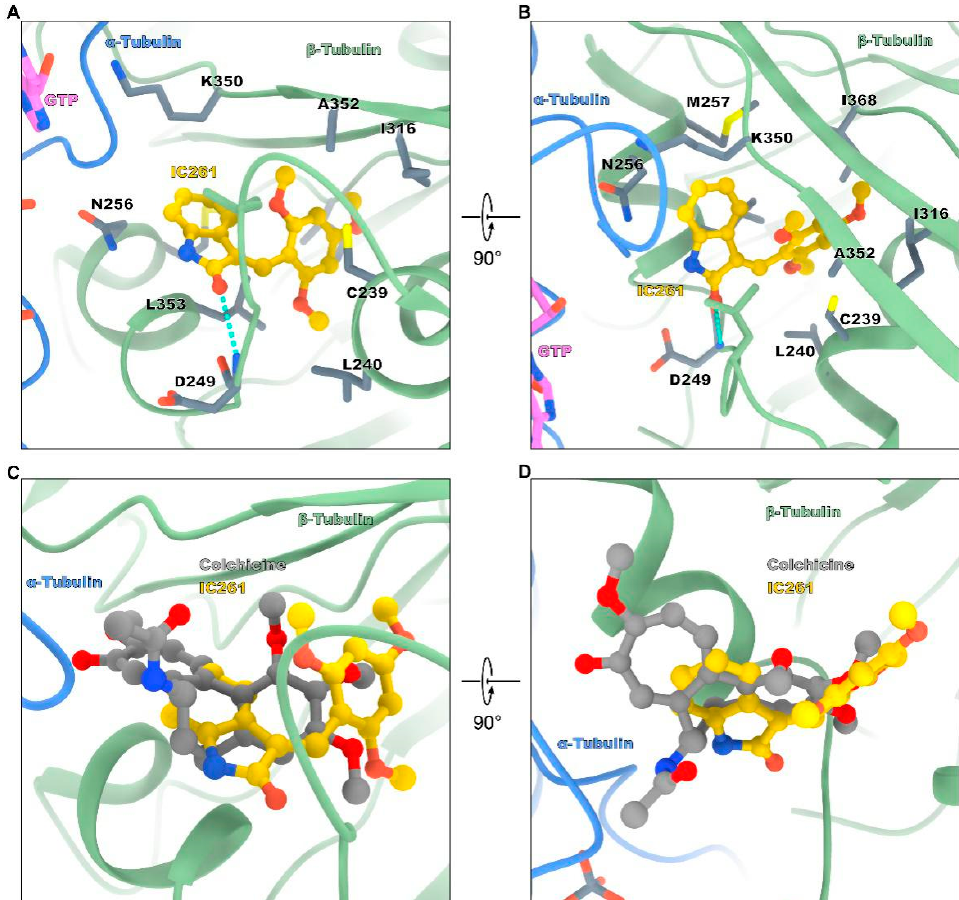
Figure 2. Interactions between IC261 and tubulin, and comparisons of the binding modes between IC261 and colchicine. The two colchicine binding site inhibitors (CBSIs) are shown as sticks. Tubulin, IC261, and GTP are colored as in Figure 1 represented by sticks. Interacting residues of tubulin are shown in stick representation and are labeled. Colchicine is colored in grey. Oxygen atoms of the compounds are colored in red and nitrogen atoms in blue. ( A , B ) Intermolecular interactions of the binding mode between IC261 and tubulin. ( C , D ) The complex structures of tubulin-IC261 and tubulin-colchicine (PDB ID: 4O2B) are